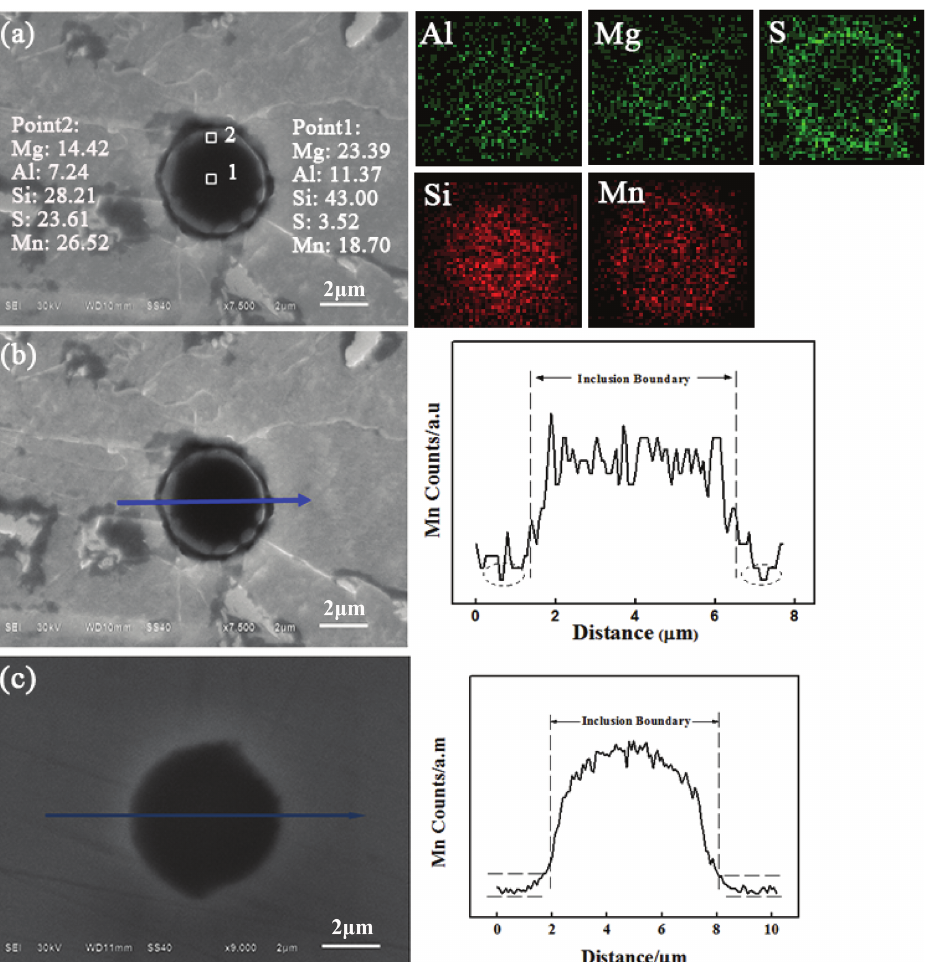
Figure 4: (a) The SEM micrograph and EDS mapping images for typical Mg-bearing inclusion in Mg-treated sample after etching, (b) EDS Line analysis of Mn along the nucleation site of Mg-bearing inclusion and surrounding steel matrix, (c) SEM micrograph, and EDS Line analysis of Mn along inclusion and surrounding steel matrix for typical Al-Si-Mn-O inclusion in comparison